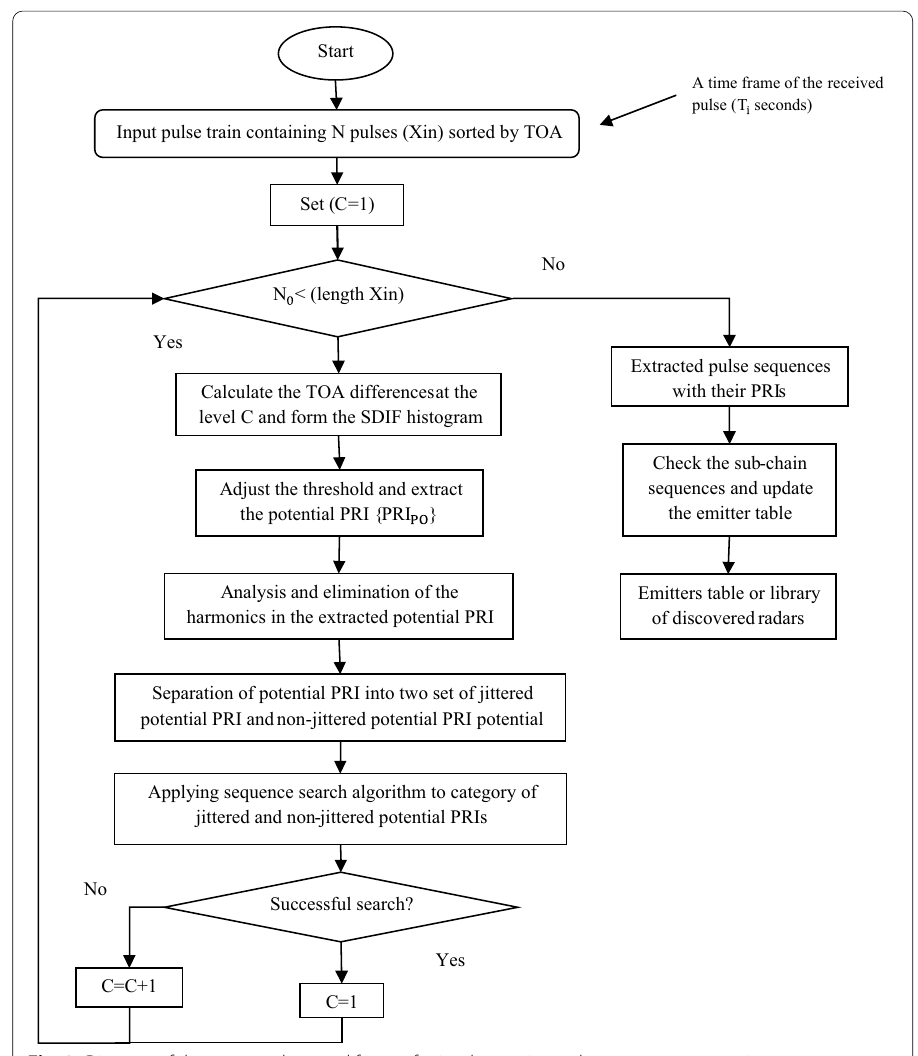
Fig. 3 Diagram of the proposed general format for implementing pulse sequence